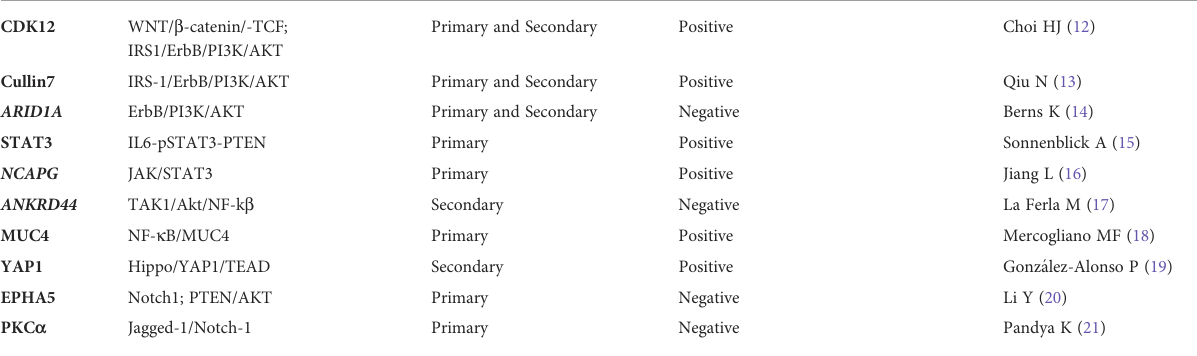
Emerging biomarkers for predicting trastuzumab resistance through bypass pathway activation. Biomarkers Mechanism/signaling pathway Primary/secondary drug Correlation with drug resistance Author and resistance